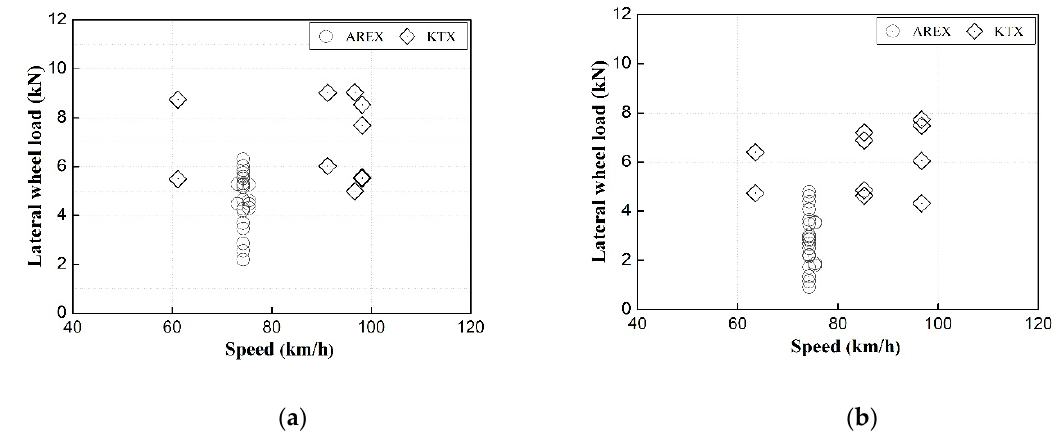
Figure 6. Measured lateral wheel load by train type. ( a ) Before rail pad replacement and ( b ) after rail pad replacement.